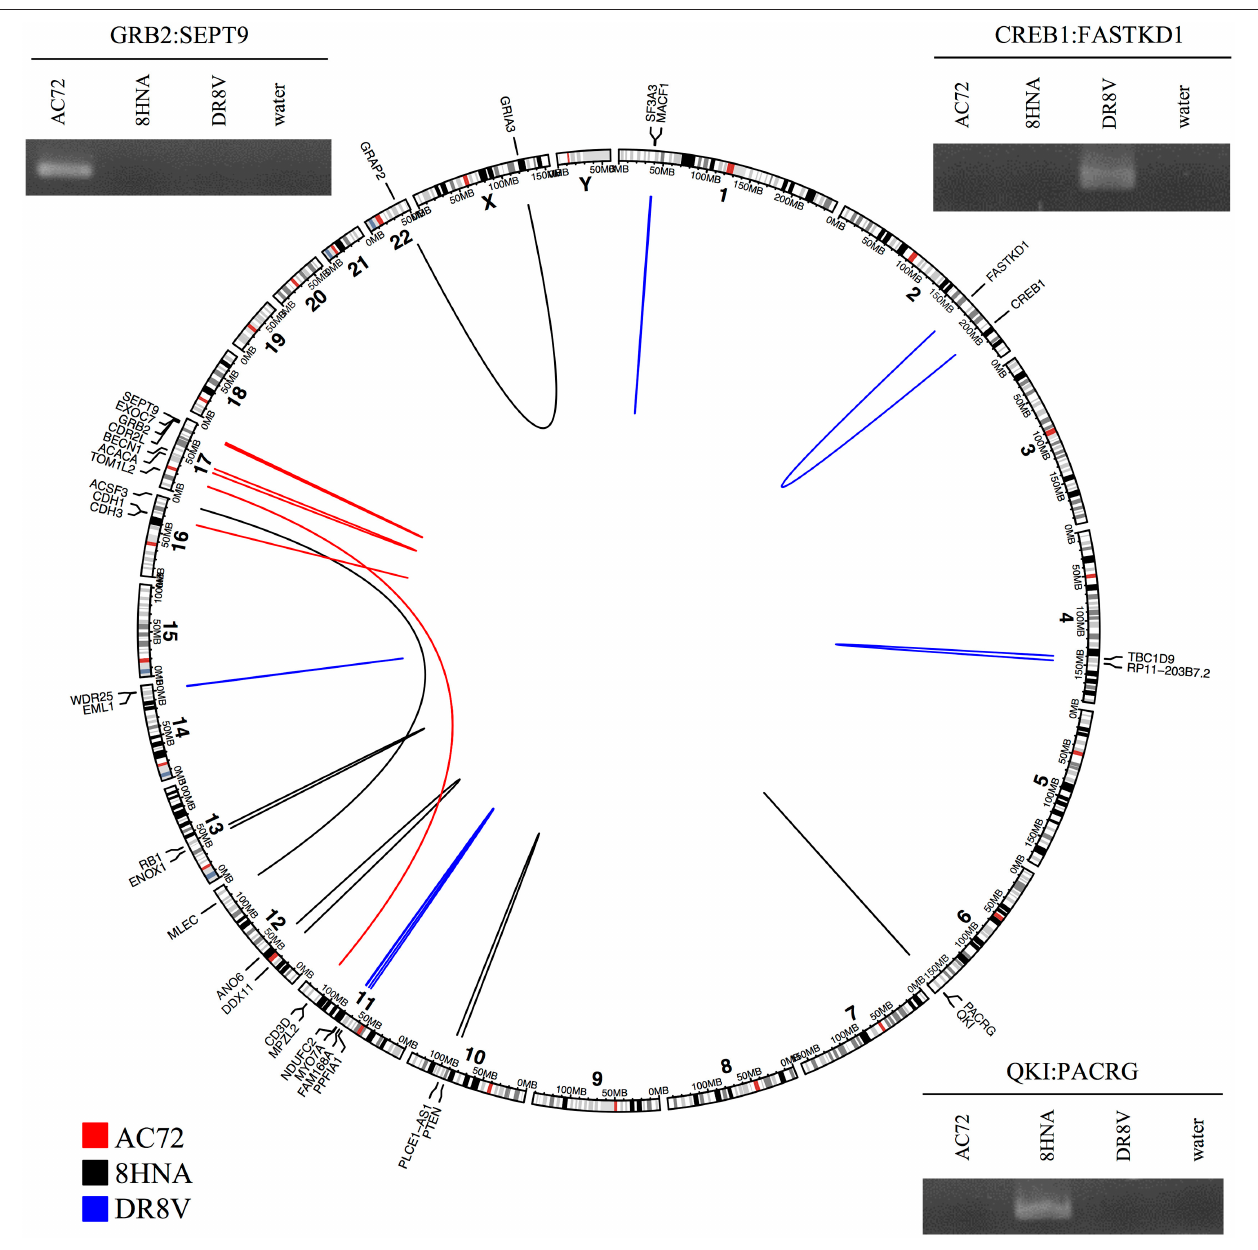
FIGURE 8 | Eighteen high-confidence fusions validated by RT-PCR followed by Sanger sequencing in three primary breast tumor samples. Circular layout is based on tool (Gu et al., 2014).